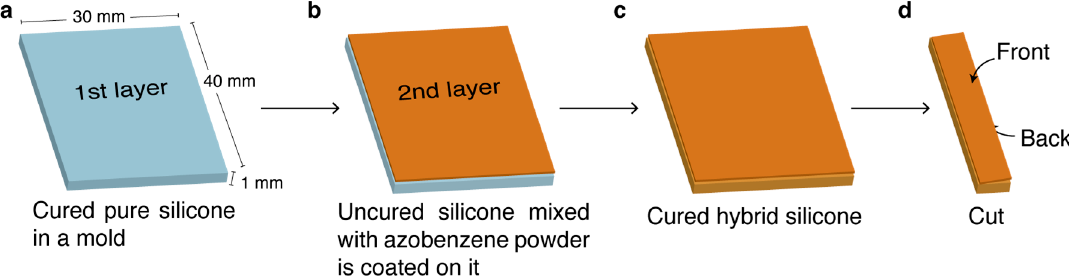
Figure 1. Preparation of a hybrid silicone mixed with azobenzene powder. ( a ) Curing the first layer. ( b ) Coating uncured silicone containing azobenzene powder as the second layer. ( c ) Obtained hybrid silicone after curing the second layer. ( d ) Cutting for bending observations.